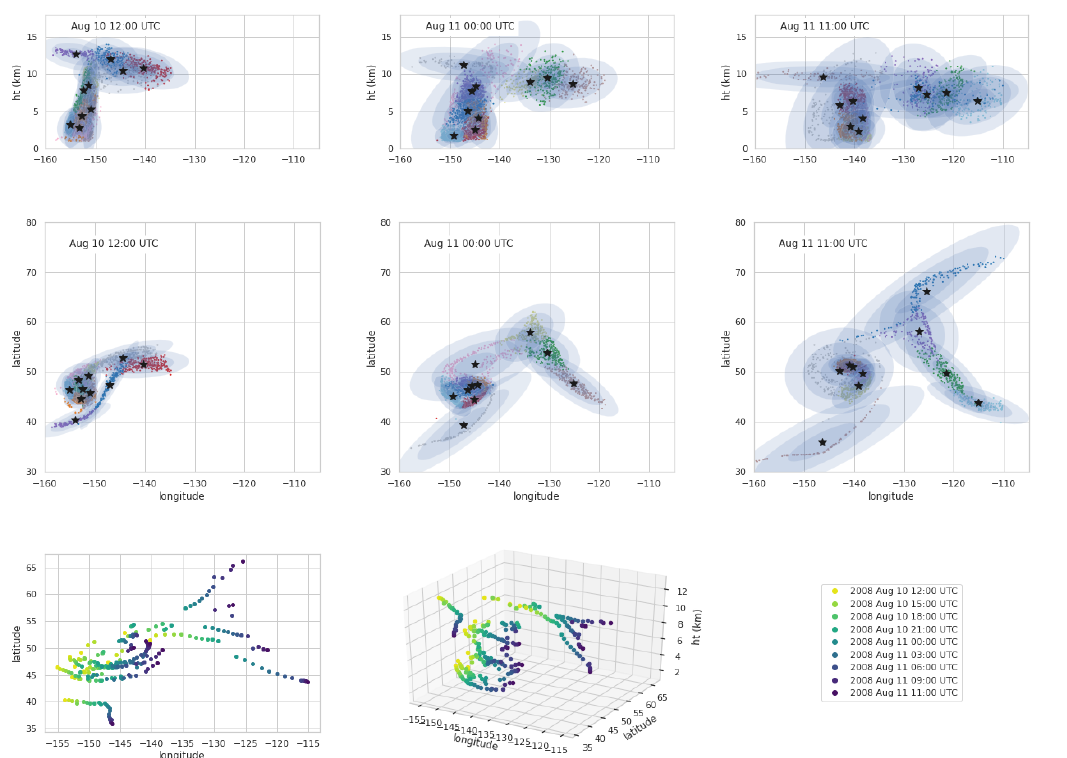
Figure 9. The top two rows show features identified by a BGMM with 10 Gaussians at three times. The black stars show the centers of the Gaussians. The colored dots indicate the position of the computational particles. The different colors belong to different groups. The width of each Gaussian is indicated by the blue shaded regions. The top row is a projection onto the height-longitude plane while the second row is a projection onto the latitude-longitude plane. The bottom row shows the position of the centers of the 10 Gaussians every hour from 10 August 12 UTC to 11 August 11 UTC. The plot in the left corner is a projection onto the latitude-longitude plane while the plot on the right is a three dimensional rendering of the